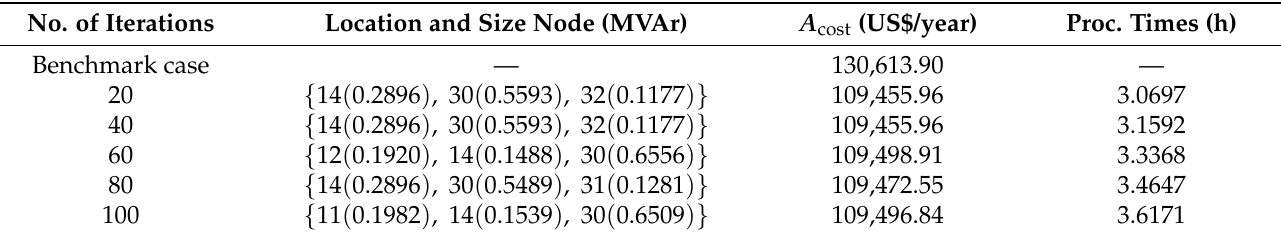
Table 4. Performance of the CBGA-SOCP approach with different population sizes.